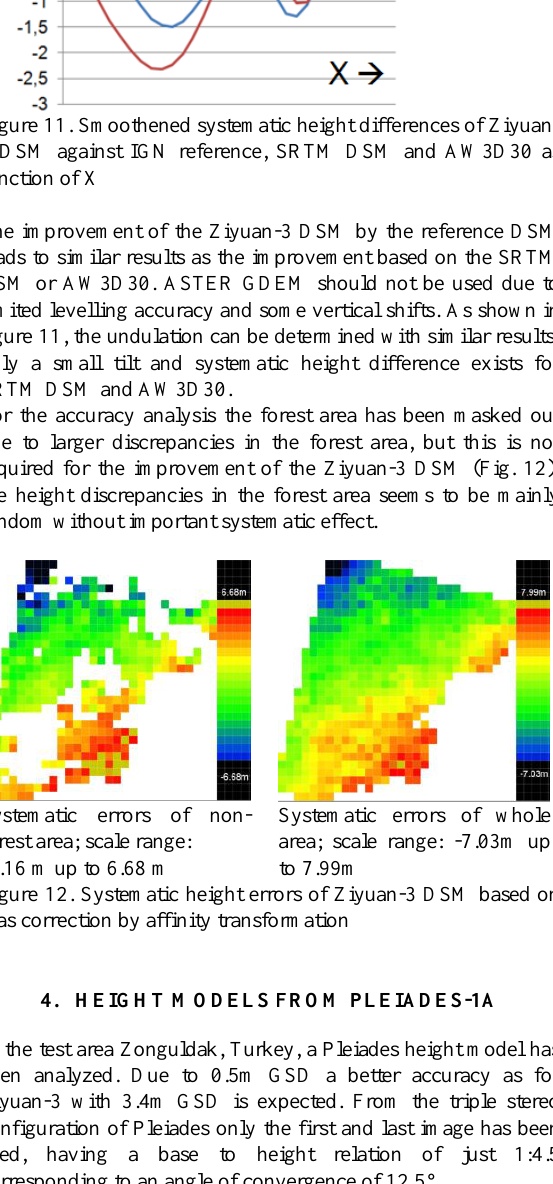
Figure 10. Ziyuan-3 DSM based on bias correction by affinity transformation The model tilt is also obvious by the colour coded height differences (Fig. 10 left). Based on the height differences against the reference height model a levelling is possible (Fig. 10 right).